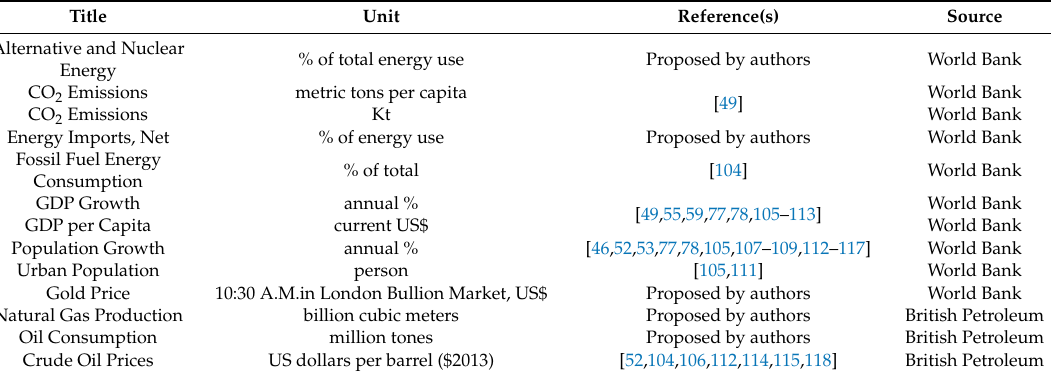
Table 3. Initialize input